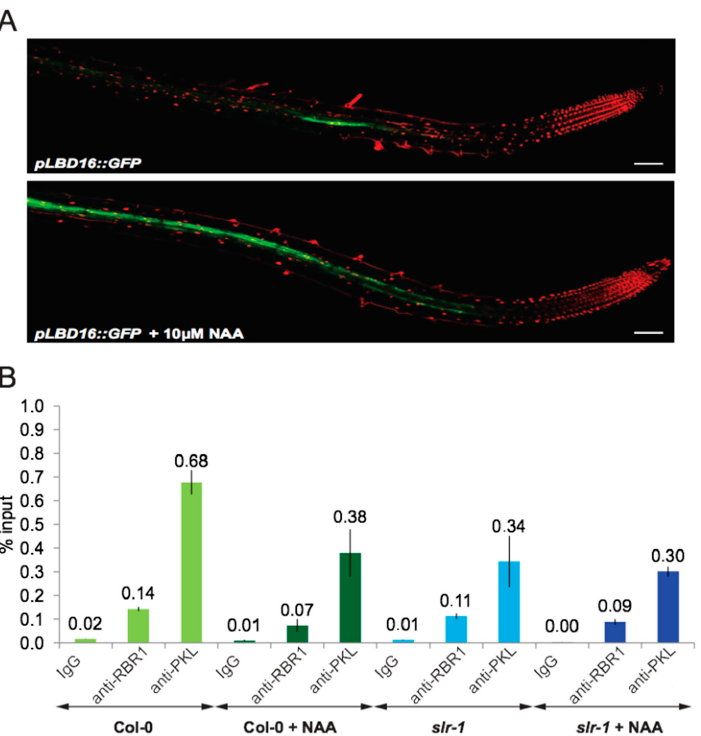
Figure 7. LBD16 promoter activation upon NAA treatment. ( A ) Confocal microscopic images of 10 DAG Col-0 roots expressing the pLBD16::GFP construct with or without 10 µ M NAA. Scale bar = 100 µ m. ( B ) ChIP-qRT-PCR analysis of changes of RBR1 and PKL binding to LBD16